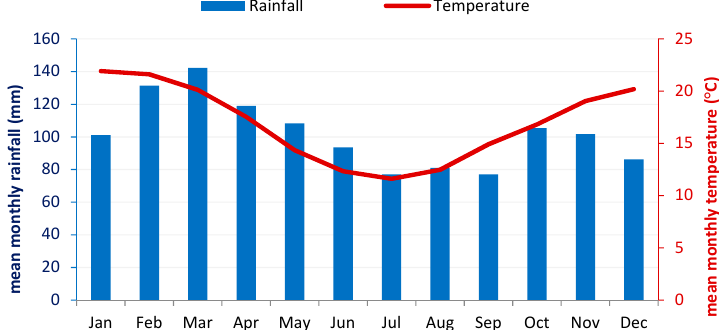
Figure 3. Monthly data for temperature and precipitation for Wandandian area during this study period show that the highest seasonal temperature occurs during the south hemisphere summer, particularly in January and February. At the same time, February and March are the wettest months in the records [15,24,30]. The reported local mean sea level rise (MSLR; Figure 4d) is caused by global warming and climate change [2,29]. It is based on mean water level relative to the nearest local tide gauging station at Port Kembla, which is located ~45 km away but has an observation record extending from 1957 to recent [31].